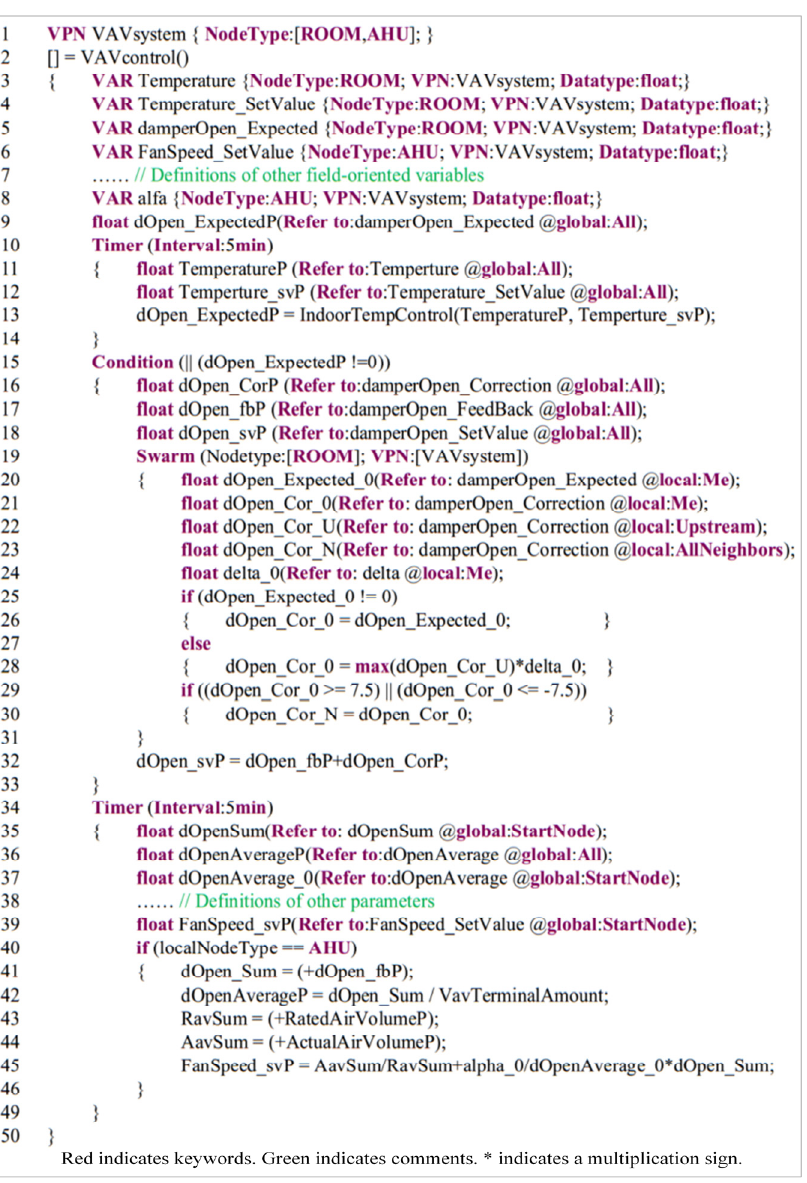
Figure 14. VAV optimization control